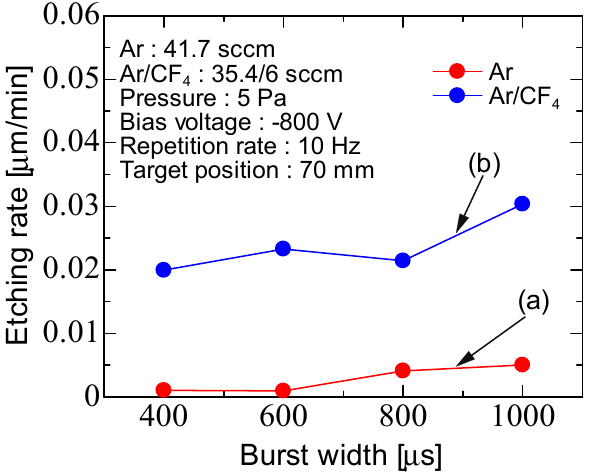
Figure 10. Burst width characteristics of the etching rate for ( a ) Ar discharge and ( b ) Ar/CF 4 discharge with fixed repetition rate (10 Hz).